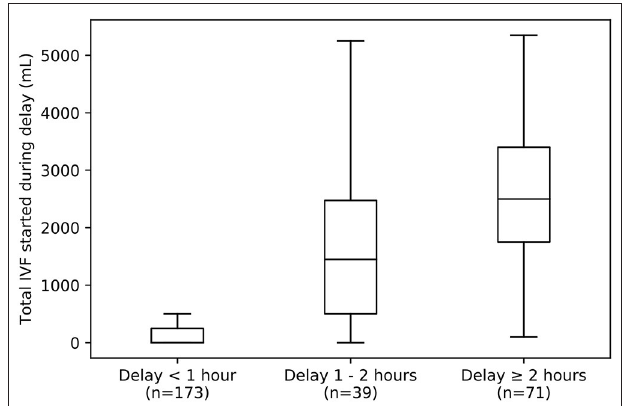
FIGURE 5 | Box-plot summarizing distributions of IVF volumes given to VP > 24 patients during delays of varying lengths between reaching a UCV model threshold of 0.8 and initiation of vasopressor therapy. Left: Most ED patients receive vasopressors within 1 h after reaching this threshold ( n = 110 out of 283 VP > 24 patients who reached a threshold of 0.8) and receive little IVF in that time (median 0 mL, IQR 0 – 250 mL). Middle and Right: However, a large minority experience delays of 1 to 2 h (middle, n = 39) or even greater than 2 h (right, n = 71), and these patients tend to receive large IVF volumes (median 1,450 mL, IQR 500–2,475 mL for those with delays of of 1 to 2 h, and median 2,500 mL, IQR 1,750–2,400 mL for those with delays of 2 h or more). IVF, intravenous